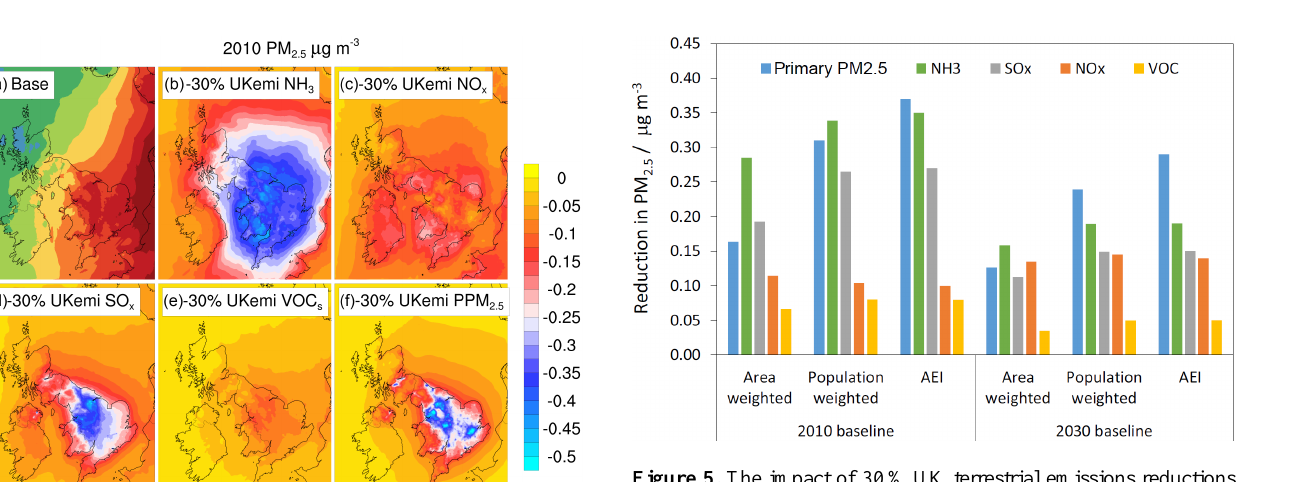
Figure 5. The impact of 30% UK terrestrial emissions reductions in primary PM 2 . 5 , NH 3 , SO x , NO x , and VOC (individually) on three measures of UK-average surface concentrations of PM 2 . 5 : area weighted; population weighted; and the average for the 45 model grids containing the monitors used to calculate the UK PM 2 . 5 average exposure indicator (AEI). Data are shown for simulations for 2010, and for 2030 under a CLE emission scenario (using 2010